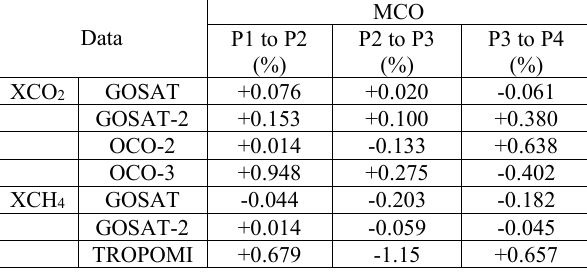
Table 2. Differences of average XCO 2 and XCH 4 during MCO